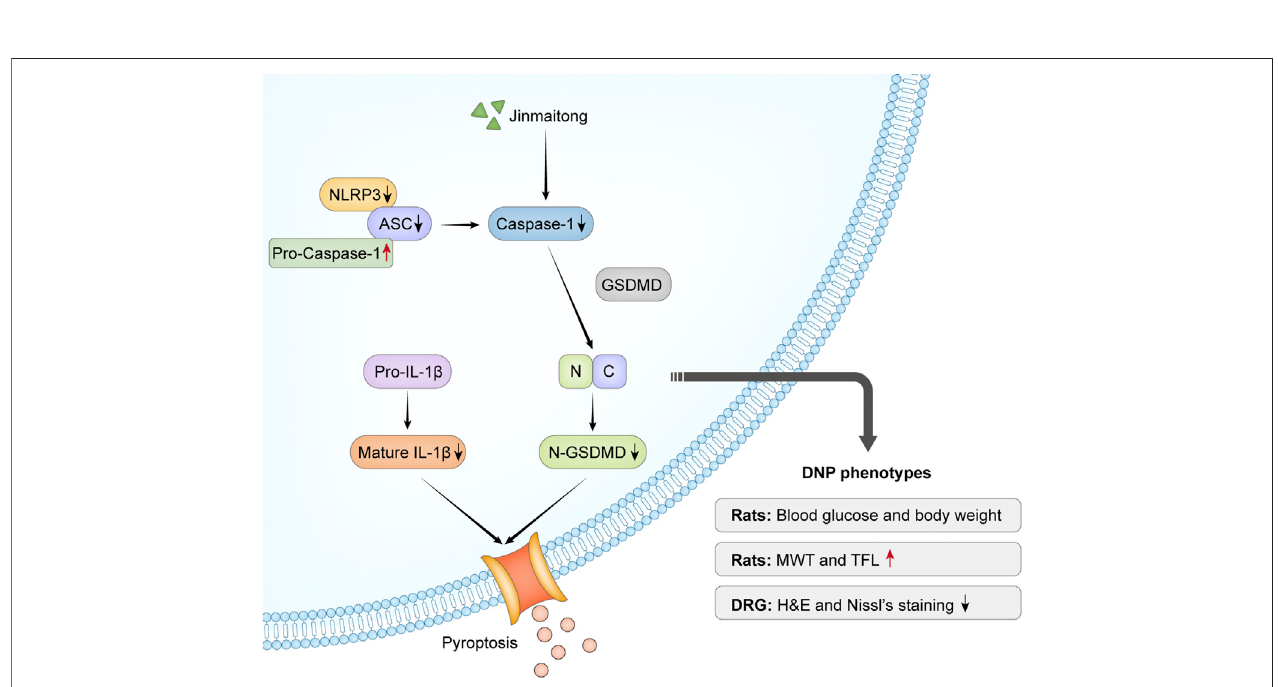
FIGURE 7 | Overview mechanism of neuroprotective effects of JMT on DNP. Chronic hyperglycemia stimulated NLRP3 in fl ammasome activation, which led to nociceptive behavior and morphological injury in diabetic rats. The activation of caspase-1 induced by NLRP3 in fl ammasome promoted IL-1 β secretion and GSDMD cleavage.JMTeffectivelyrelievedDNPthroughthedownregulationofNLRP3in fl ammasomeactivationandpyroptosis.Redarrowsindicateup-regulationbyJMT,black arrows show down-regulation by JMT.